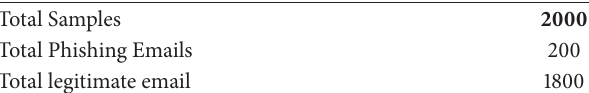
Table 1: Data used for